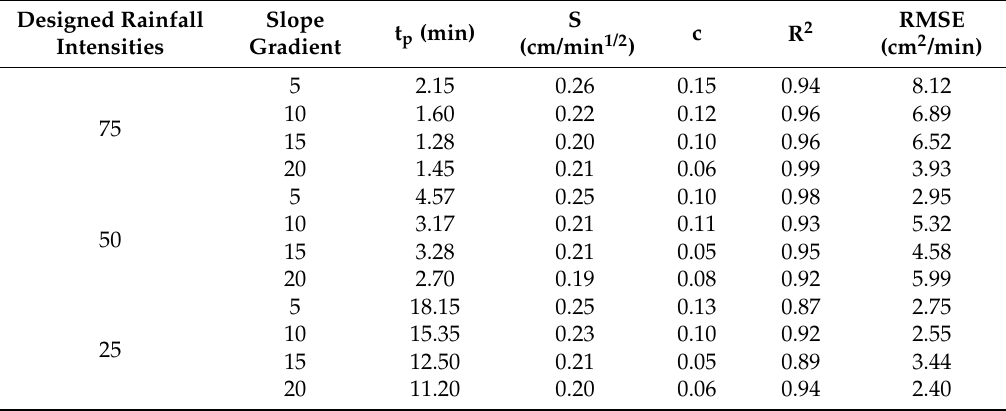
Table 3. The initial time to runoff (t p ), adsorptivity (S), R 2 and RMSE obtained by curve-fitting the results of the runoff model under different rainfall intensities and slope